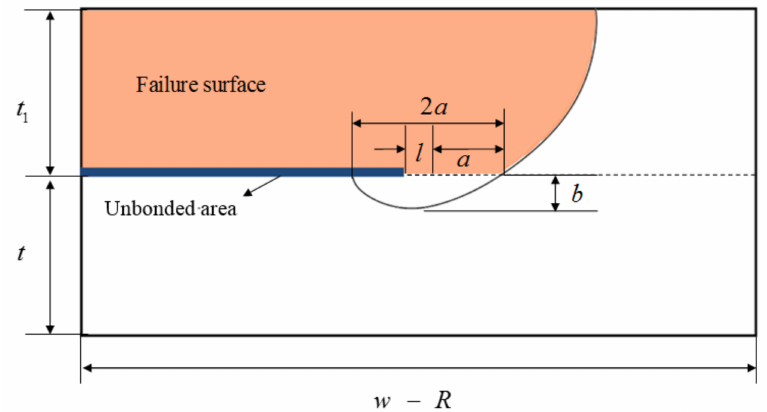
Figure 12. Modified predictor area and parameter definition.